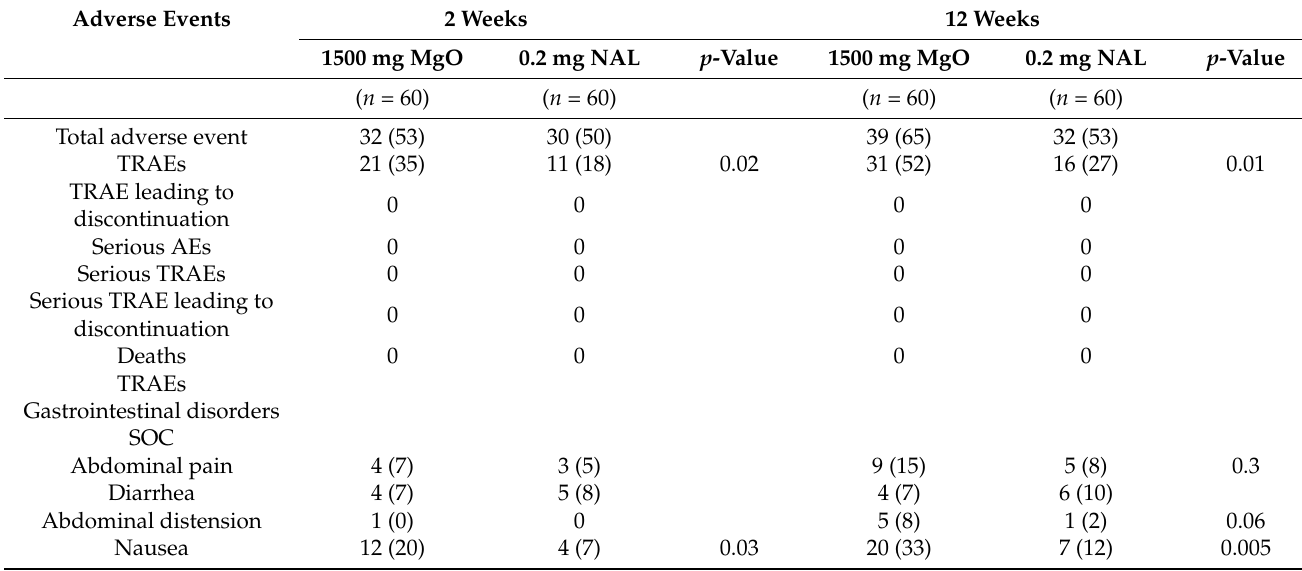
Table 3. Adverse